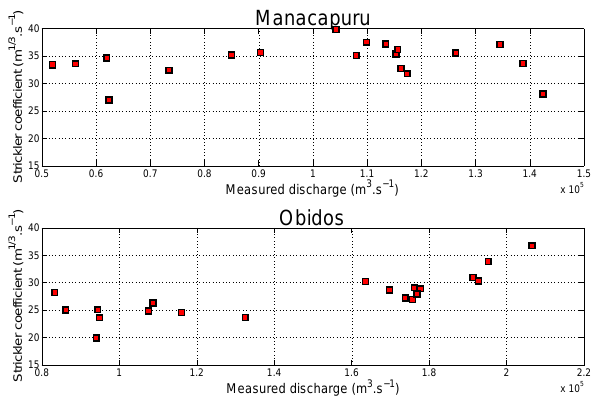
Fig. 7. Variation of the Strickler coefficient with the estimated dis- charge for the Manacapuru station dataset (top) and the Obidos sta- tion dataset